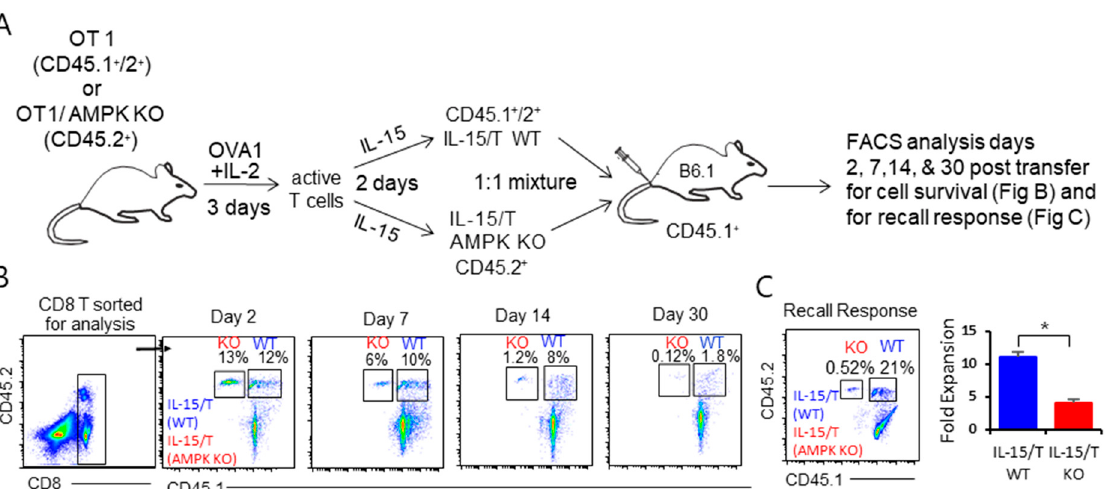
Figure 5. Characterization of the survival and recall responses of in vitro prepared WT IL-15/T M and IL-15/T M AMPK α 1 KO cells. ( A ) Schematic diagram depicting our experimental protocol of adoptive T cell transfer and downstream, kinetic flow cytometric analyses. ( B ) A 1:1 mixture of in vitro prepared WT CD45.1 + /2 + IL-15/T M and CD45.2 + IL-15/T M AMPK α 1 KO cells derived from WT CD45.1 + /2 + OTI and CD45.2 + OTI/ AMPK α 1 KO mice was adoptively transferred into one CD45.1 + B6.1 mouse. Kinetic flow cytometry was performed by first sorting the host CD8 + T cell population for further analysis of the two donor CD45.1 + /2 + WT IL-15/T M and CD45.2 + AMPK α 1 KO IL-15/T M cells at day 2, 7, 14 and 30 post T cell transfer. ( C ) Recipient mice were infected with 2000 CFUs of rLmOVA at day 30 post T cell transfer. Representative dot plots showing frequencies of transferred CD45.1 + /45.2 + WT IL-15/T M and CD45.2 + AMPK α 1 KO IL-15/T M cells among the host CD8 + T cells by flow cytometry at day 4 after rLmOVA challenge. Bar graphs represent fold expansion of the T cell numbers at day 4 post the rLmOVA boost versus the T-cell numbers at day 30 post T-cell transfer. Data are presented as mean ± SD ( n = 3/group). * p < 0.05 by two-tailed Student t test. One representative experiment of two is shown.